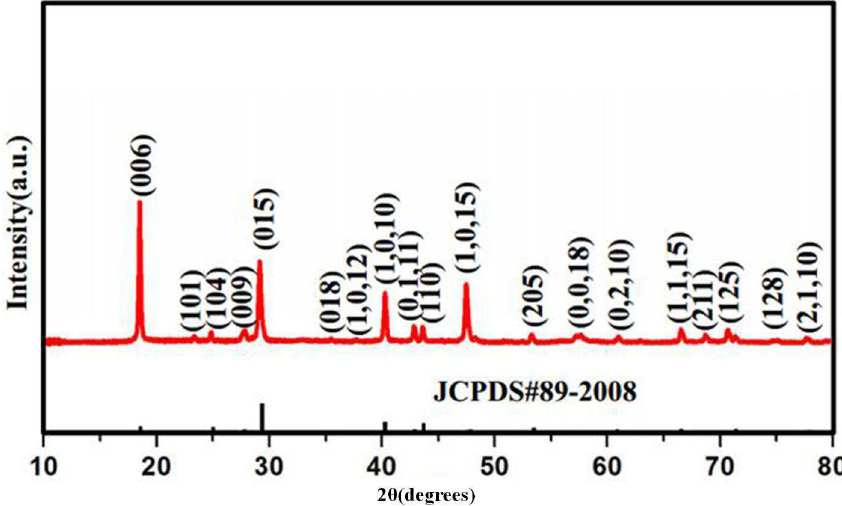
Figure 1. XRD pattern of as-prepared Bi 2 Se 3